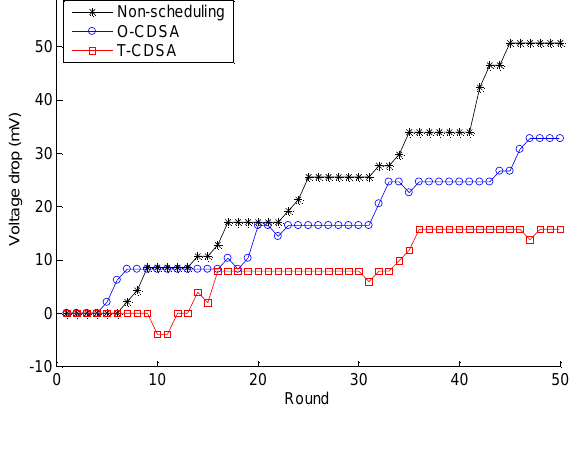
Figure 15. Average voltage drop of node 12 from the three schemes at each